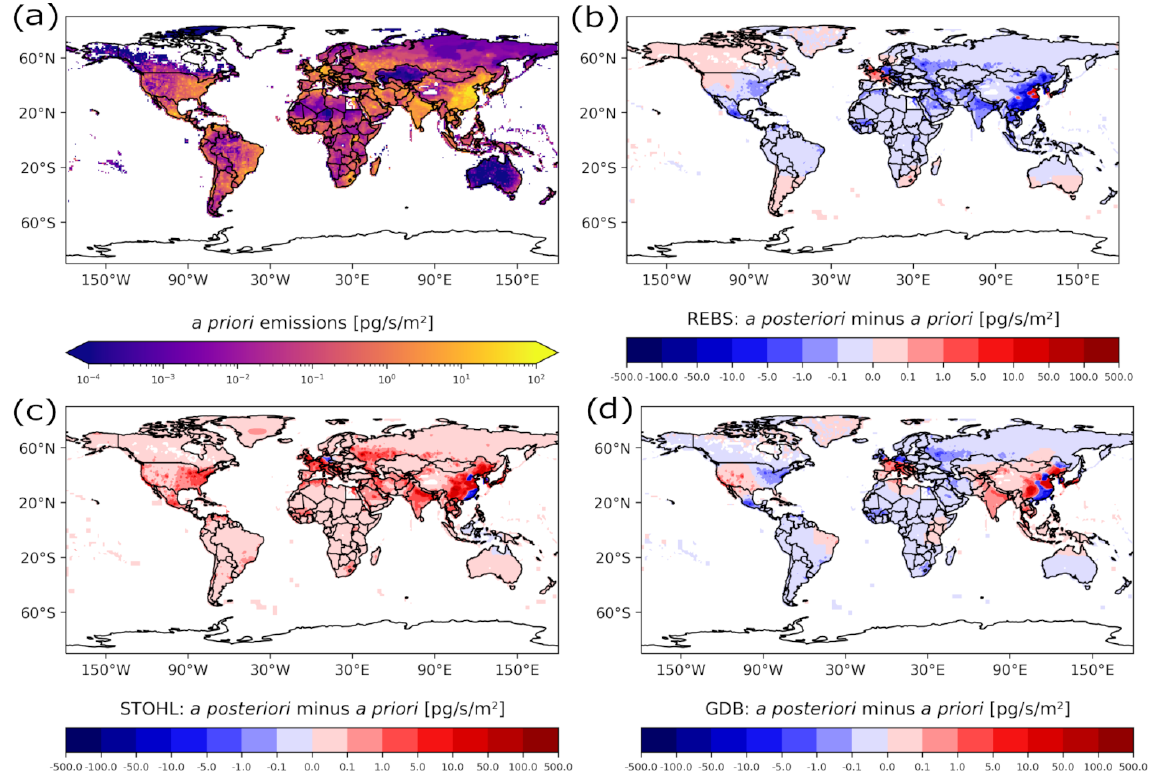
Figure 8. A priori SF 6 emissions (a) and SF 6 emission increments given by the inversion when using the REBS method (b) , Stohl’s method (c) , and the GDB method (d) based on 20d LPDM backward